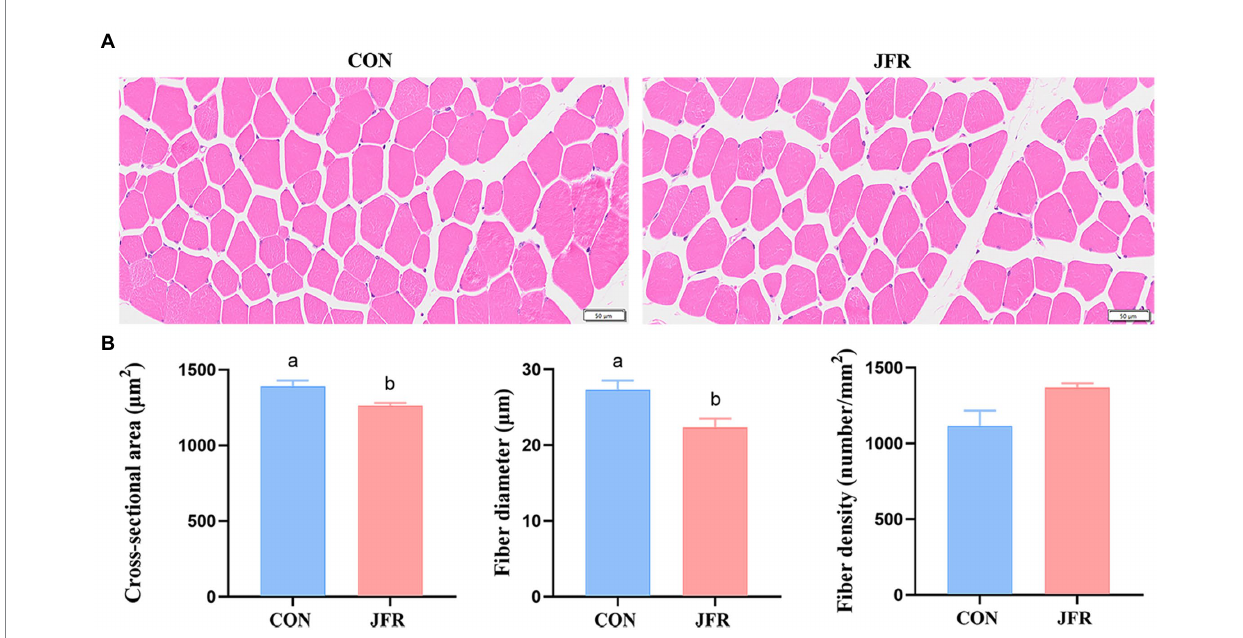
FIGURE 1 Effect of JFR on muscle fiber characteristics. (A) Hematoxylin and eosin staining of longissimus dorsi muscle (Bar = 50 μ m). (B) Statistical results of cross- sectional area, diameter and density of muscle fibers. The values with different letters (a and b) are significantly different ( p <